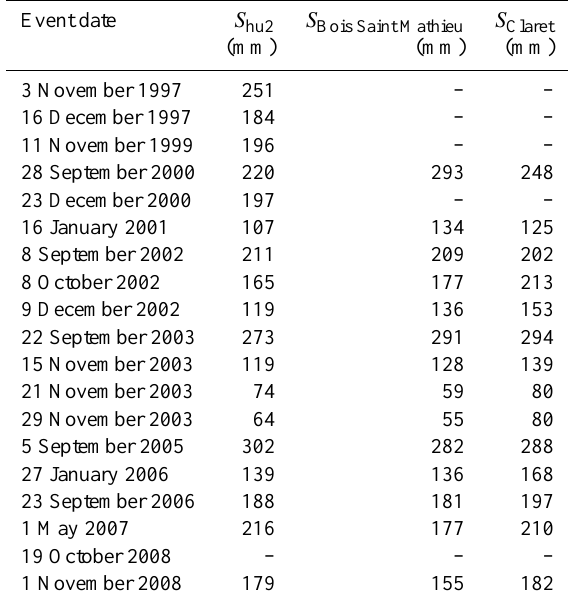
Table 3. S reg estimated from physical indicators of the catchment wetness state using the linear regressions presented in Table 2. Dashes indicate missing